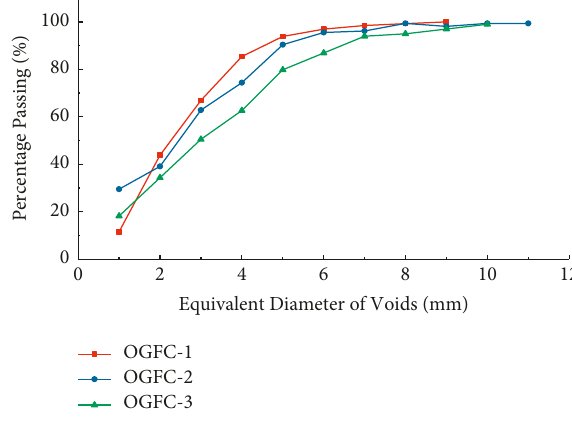
Figure 8: Void gradation diagram.